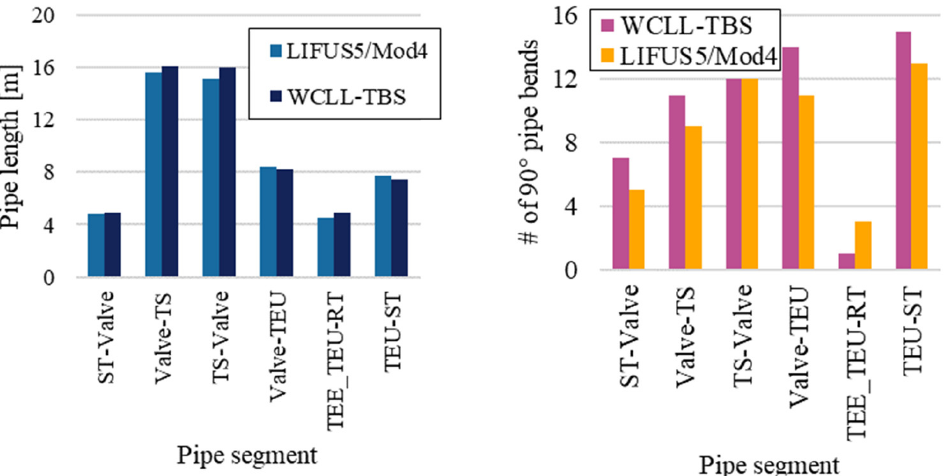
Figure 3. L5M4–TBS piping comparison. Left : comparison between main lines length. Right : comparison of the number of 90° bends between the two piping systems.